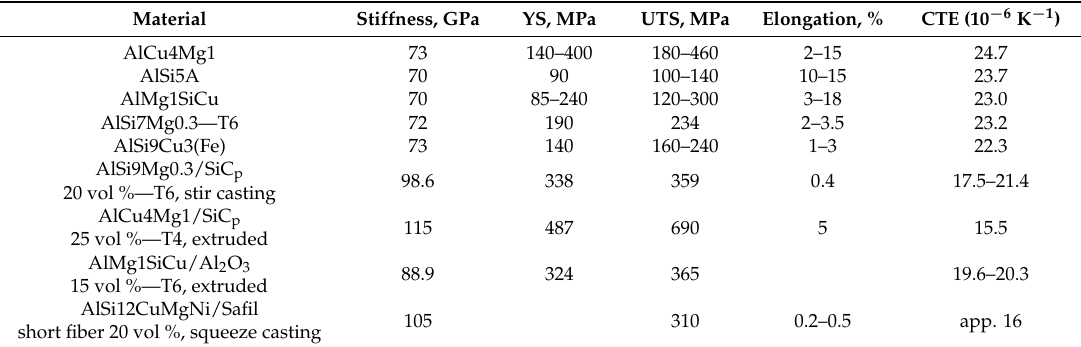
Table 1. Properties of Al alloys and AlMCs for automotive application